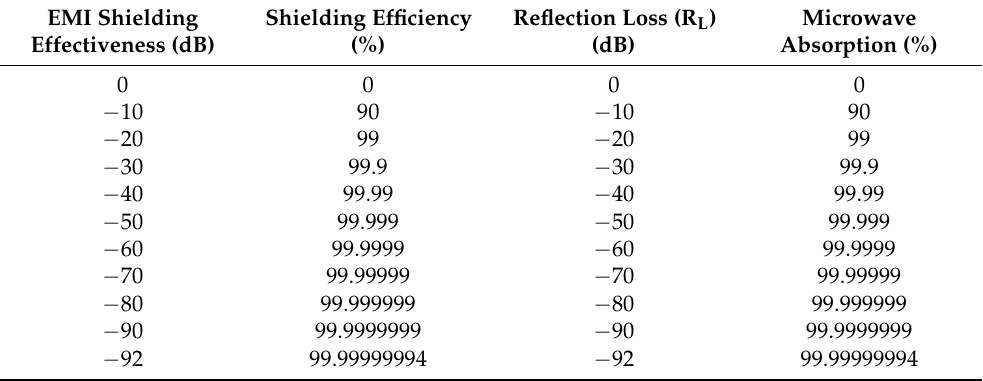
Table 1. The correlation between the EMI shielding effectiveness value (dB) with shielding efficiency (%) and the reflection loss (R L ) value with microwave absorption (%). Reprinted/adapted with permission from Ref [90]. Copyright 2016, The American Association for the Advancement of Science. EMI Shielding Shielding Efficiency Reflection Loss (R L ) Effectiveness (dB) (%) (dB)